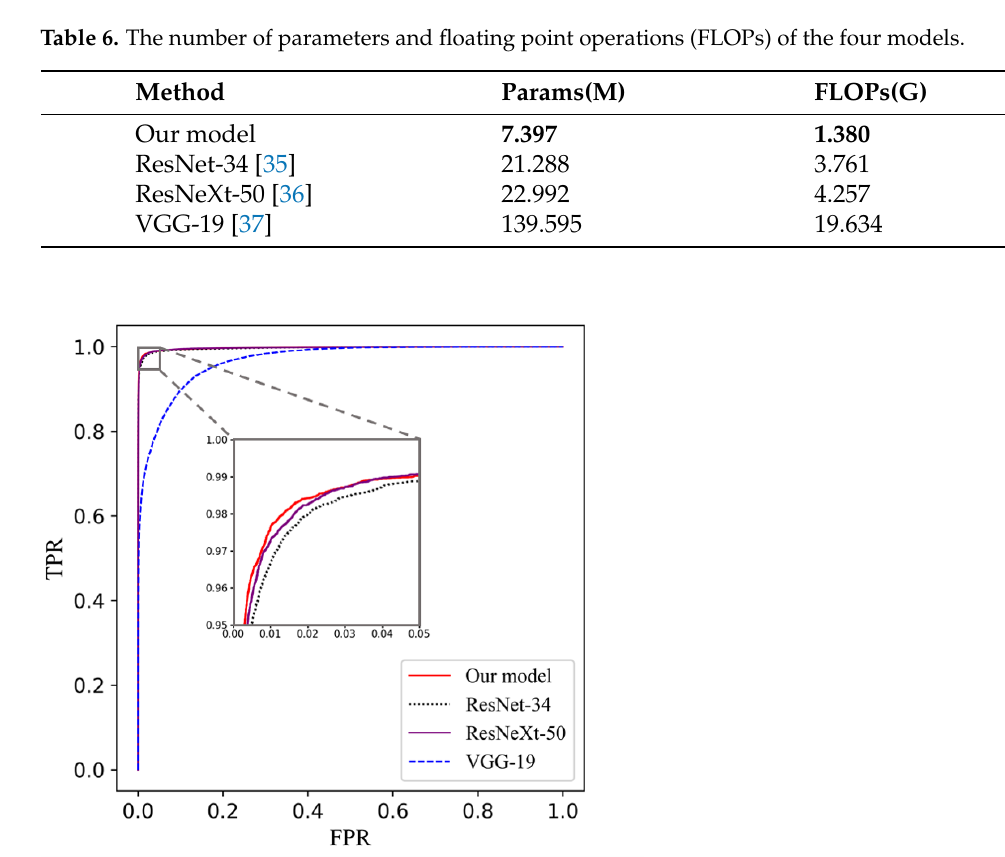
Figure 3. ROC curves of six kinds of cell classification results of the four models on the APL- Cytomorphology_LMU dataset; our model achieved an AUC of 0.9977 ± 0.0003, obtained by averag- ing the testing results of five different models trained for cross-validation. Each testing set accounts for approximately 20% of the dataset and does not have repetitive cell